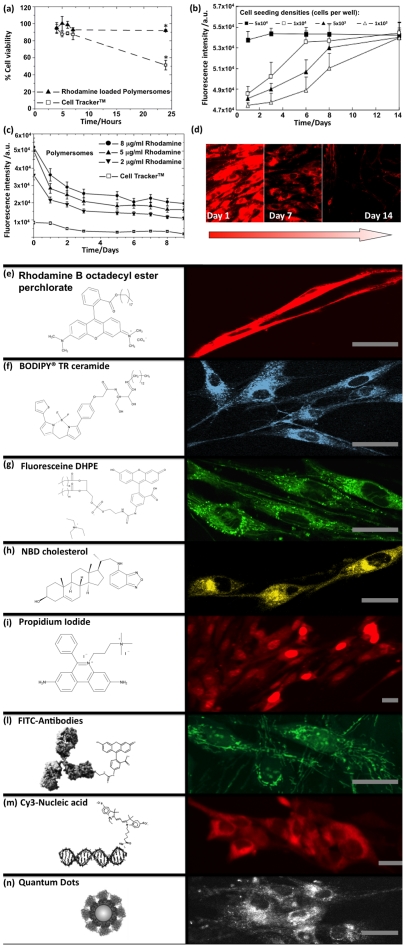
Tracking period and cytotoxicity induced by polymersome-mediated staining compared with commercial method.(a) Cell viability determined by MTT assay at different times for HDF cells exposed to either Rhodamine-loaded polymersomes or CellTracker (n = 3, error bar = SEM; *p<0.05). (b) Fluorescence intensity from HDF cells plated at different initial densities and exposed to daily dose of Rhodamine-loaded polymersomes (0.005 mM) (n = 3, error bar = SEM). (c) Fluorescence intensity exhibited by HDF cells after a single dose of polymersomes loaded with varying amounts of Rhodamine or CellTracker (n = 3, error bar = SEM). (d) Fluorescence micrographs of HDF cells recorded for the same exposure at different days after a single dose of Rhodamine-loaded polymersomes. (e) Fluorescence micrographs of primary HDF cells after 24 h incubation with PMPC-PDPA polymersomes loaded with membrane-staining amphiphilic Rhodamine B octadecyl ester perchlorate, (f) BODIPY TR ceramide, (g) fluorescein 1,2-dihexadecylphosphatidylethanolamine (DHPE), (h) labelled NBD cholesterol, (i) DNA staining membrane-impermeable propidium iodide, (l) FITC-labelled antibody anti α-tubulin, (m) labelled nucleic acids, (n) or large quantum dots. Figure bar = 0.02 mm.